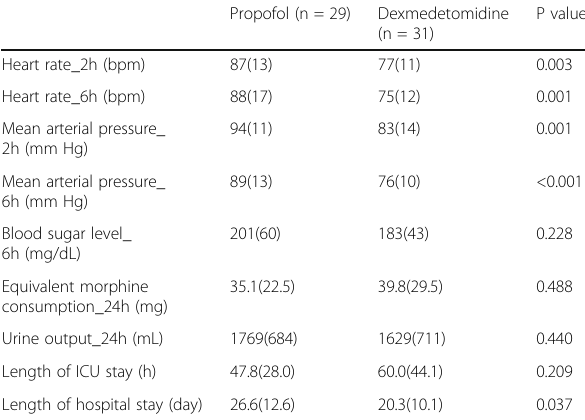
Table 53 (abstract A147). Hemodynamic Parameters and Patient Outcomes